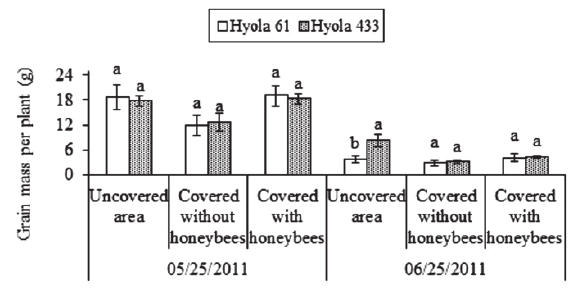
Fig. 3 - Grain mass per plant (g) of rapeseed hybrids in response to sowing dates and pollination tests. Different lowercase letters in each pollination test indicate significant differences according to the F -test ( P < 0.05).